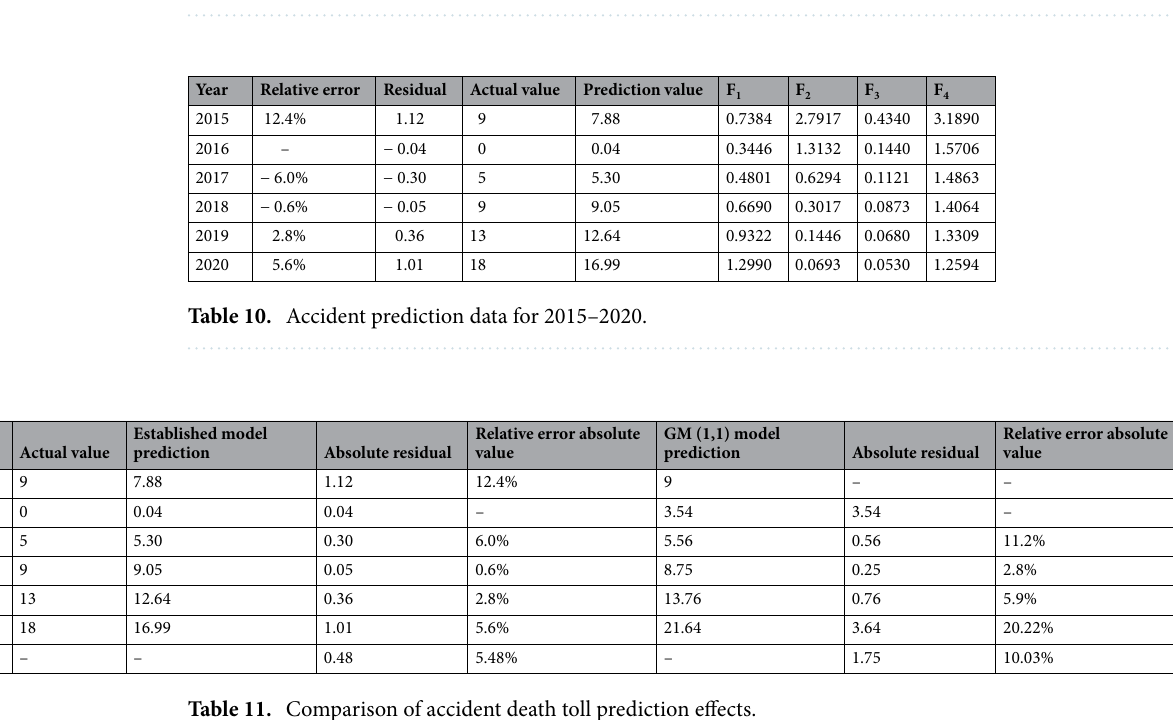
Table 9. Model summary. a Predictors: (constant),f 4 , f 3 , f 2 , f 1 .